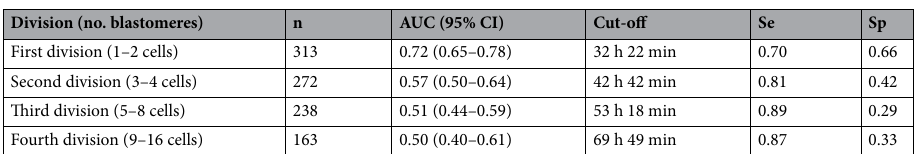
Table 2. Receiver operating characteristics (ROC) and area under the curves (AUC) for different cell cycle points. n = number of zygotes/embryos analyzed. Se: sensitivity, proportion of zygotes predicted with positive outcome that will be blastocyst. Sp: specificity, proportion of zygotes predicted with negative outcome that will be arrested